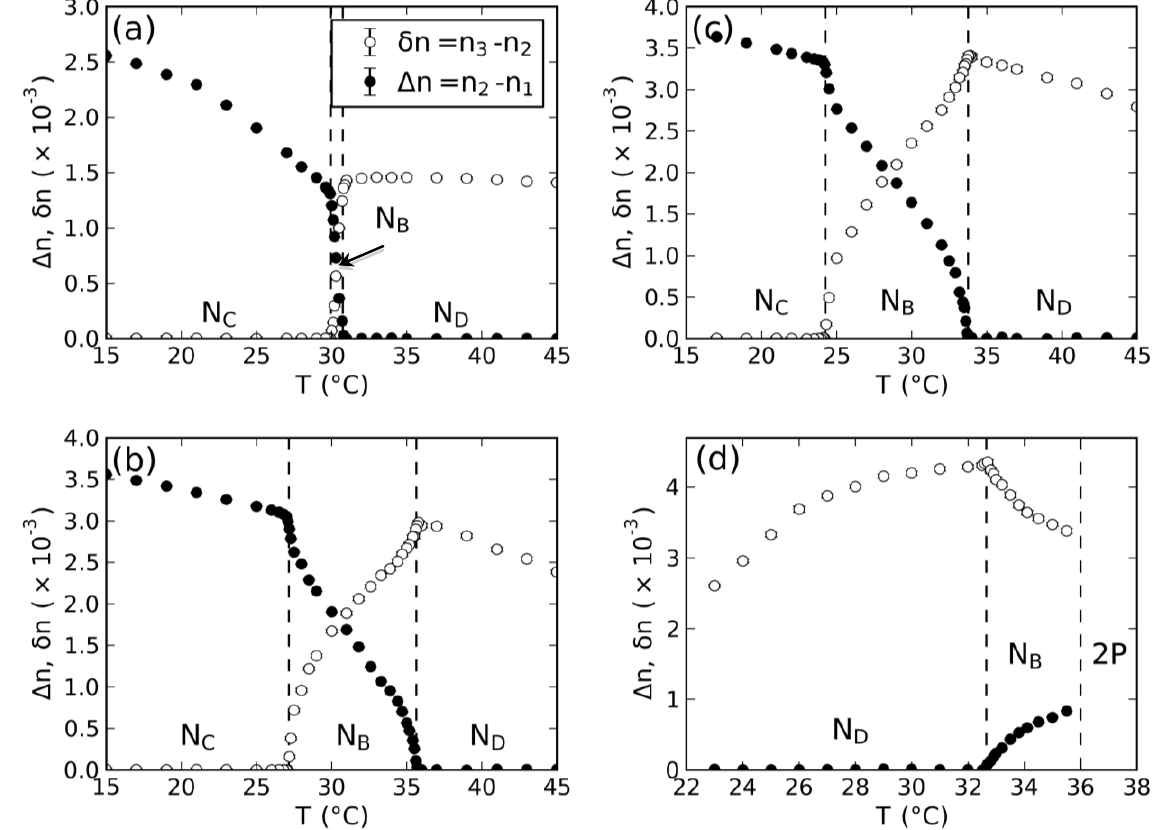
Figure 2. Temperature dependence of the birefringences of the mixtures: ( a ) potassium N -dodecanoyl- DL -alaninate ( DL -KDDA)/Cs undecanol (UndeOH)/water; ( c ) DL -KDDS/Na N -dodecanoyl- DL -aspartate ( DL -NaDDAs)/Cs coexistence